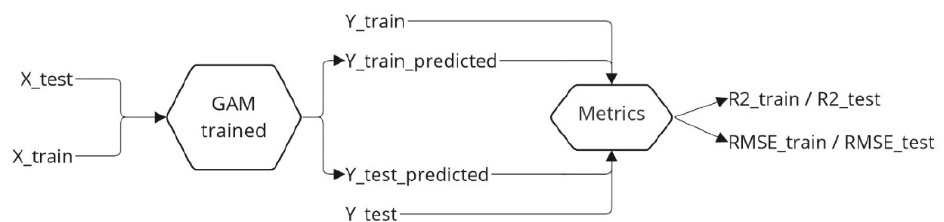
Figure 6. Unique model training.